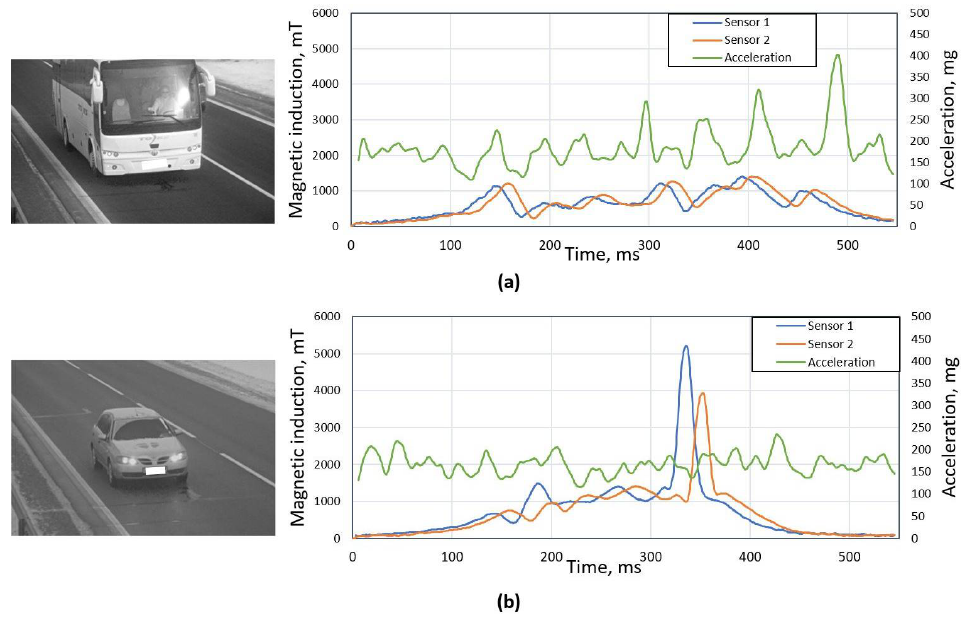
Figure 3. An example of two cases, when accelerometer criterion gives faulty result: ( a ) plot: acc ratio of 2.2 indicates distorted signature, but bus was driving perfectly at the center of sensor and magnetic signatures are not distorted; ( b ) plot: vehicle is clearly driving over the sensor therefore magnetic signatures are distorted, but from the accerometer signal it is not visible (acc_ratio = 1.43).